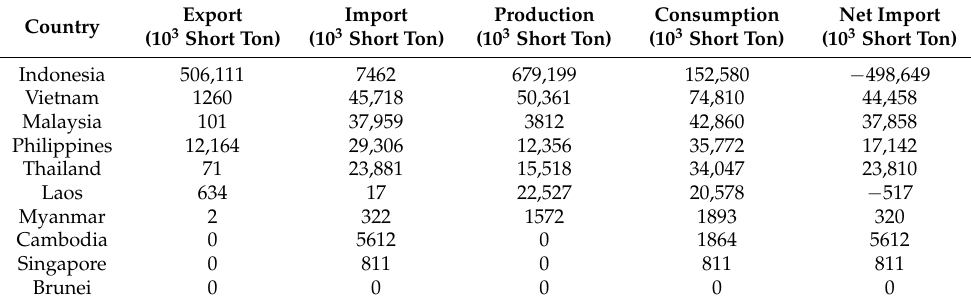
Table 3. Coal data for ASEAN countries in 2019 [41].